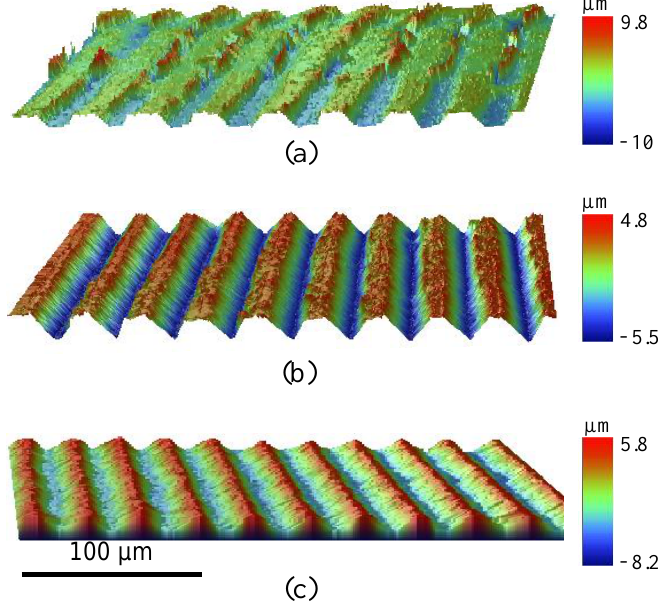
Figure 9. Veeco Dektak Stylus Profilometer 3D for LDPE films imprinted with ( a ) no heat; ( b ) 1.2 kW and ( c ) 1.6 kW.